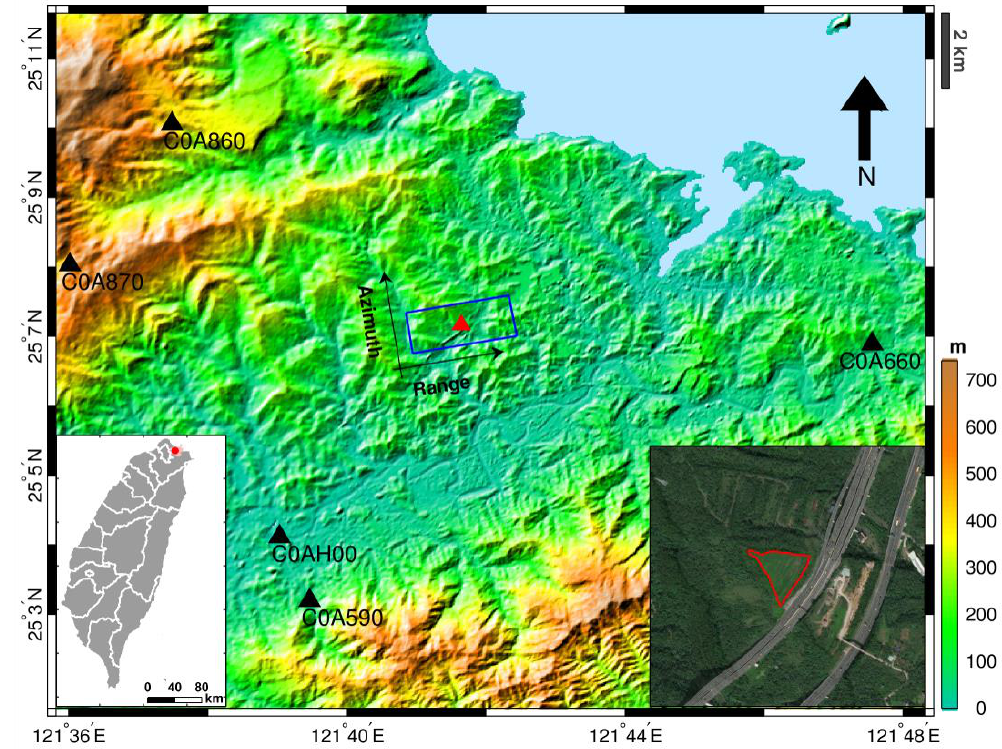
Figure 1. Shaded relief map the study area. The blue solid box represents the study area that is covered by the ascending ALOS/PALSAR dataset. The insert map to the lower left shows the location of Freeway No. 3 in Northern Taiwan. The optical image (acquired by DigitalGlobe on December 18, 2016) to the lower right shows the dense vegetation coverage. The red triangle indicates the location of the collapsed slope. The black triangles represent the meteorological sites that provide the daily precipitation data used in this study.